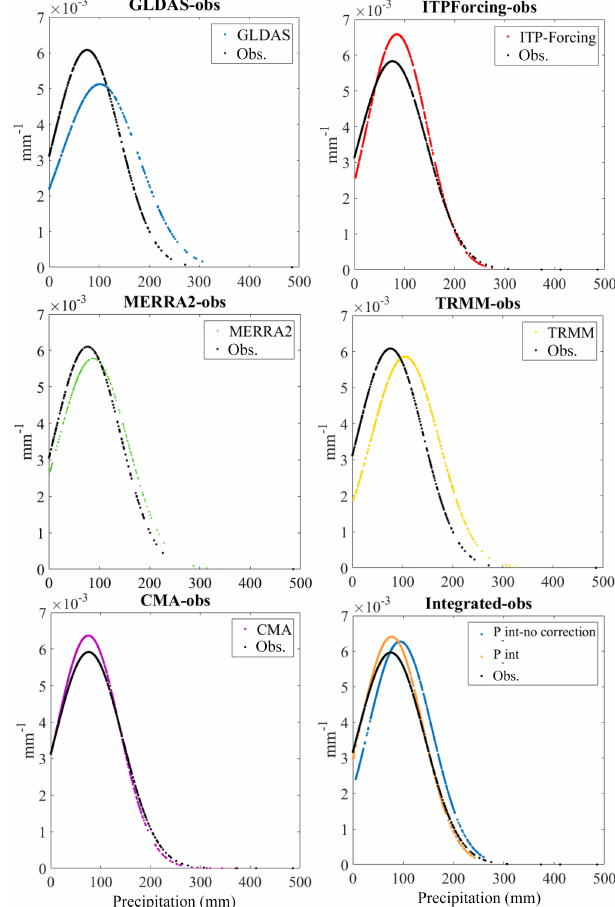
Figure 6. A comparison of the probability distribution function (PDF) between all the monthly observations and different precip- itation products in the warm seasons (May to October in 2014 and